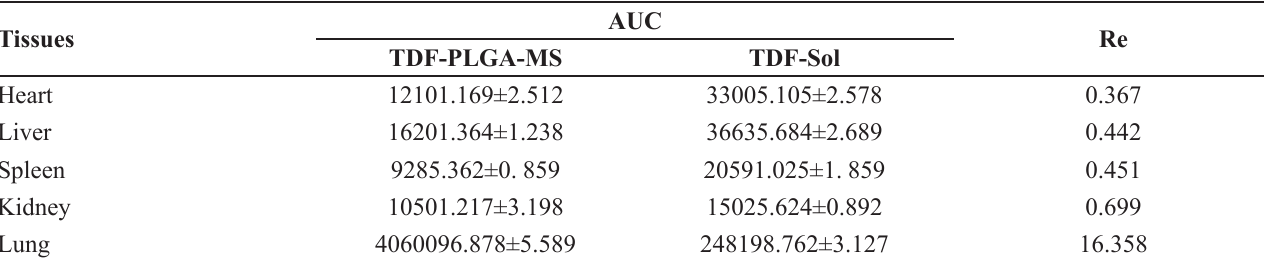
Footer: Re, namely relative uptake